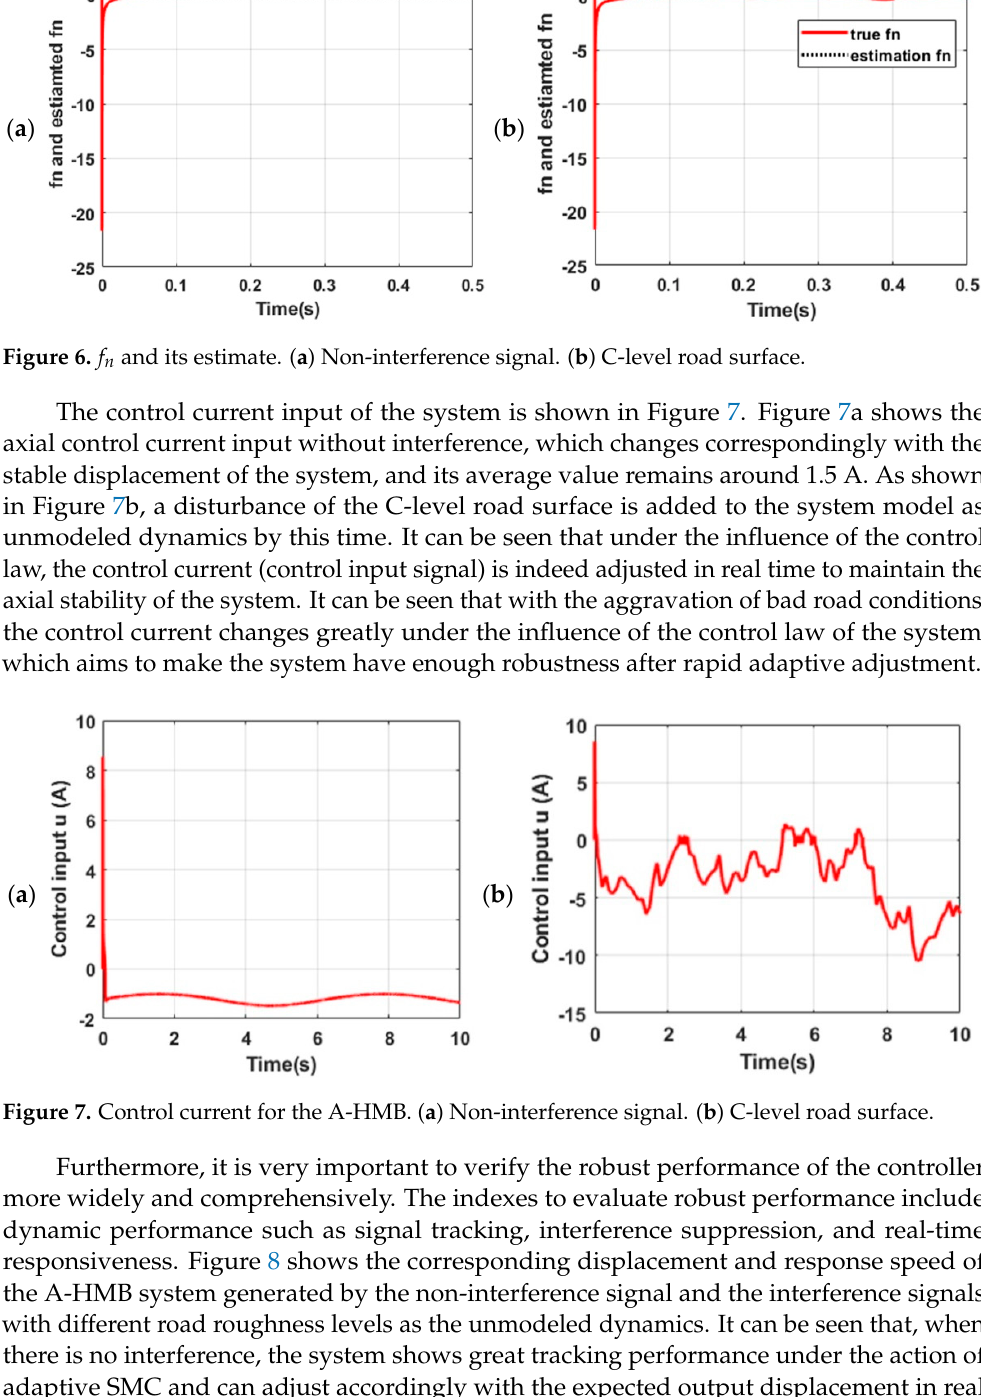
Figure 7. Control current for the A-HMB. ( a ) Non-interference signal. ( b ) C-level road